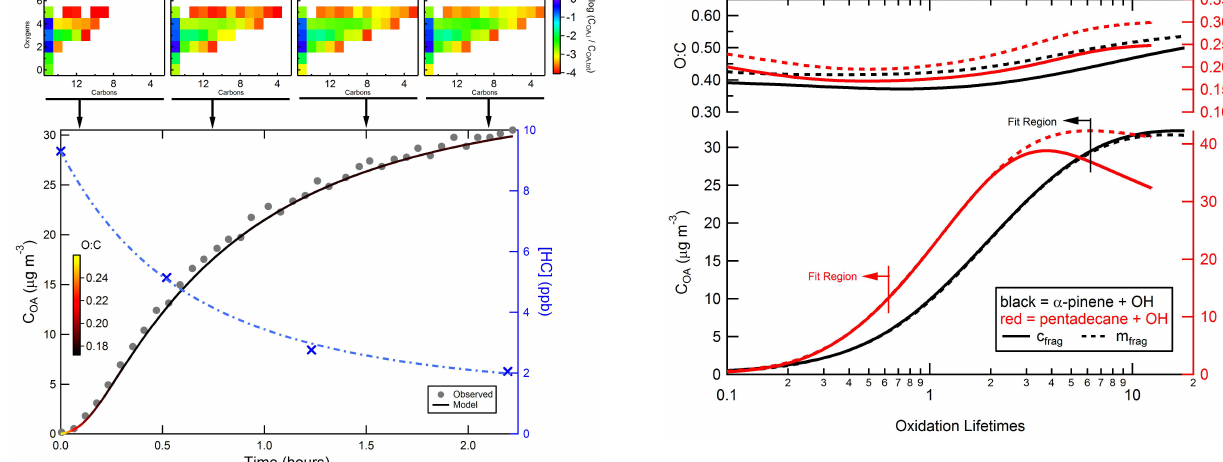
Fig. 10. Extrapolation to longer oxidation lifetimes of best-fit re- sults for the two P frag parameterizations for α -pinene + OH (black) and pentadecane + OH (red), shown for C OA and O:C. The solid lines are for P frag = c frag N O and the dashed lines for P frag = (O:C) m frag . The vertical lines indicate the point to which the model curves were constrained by